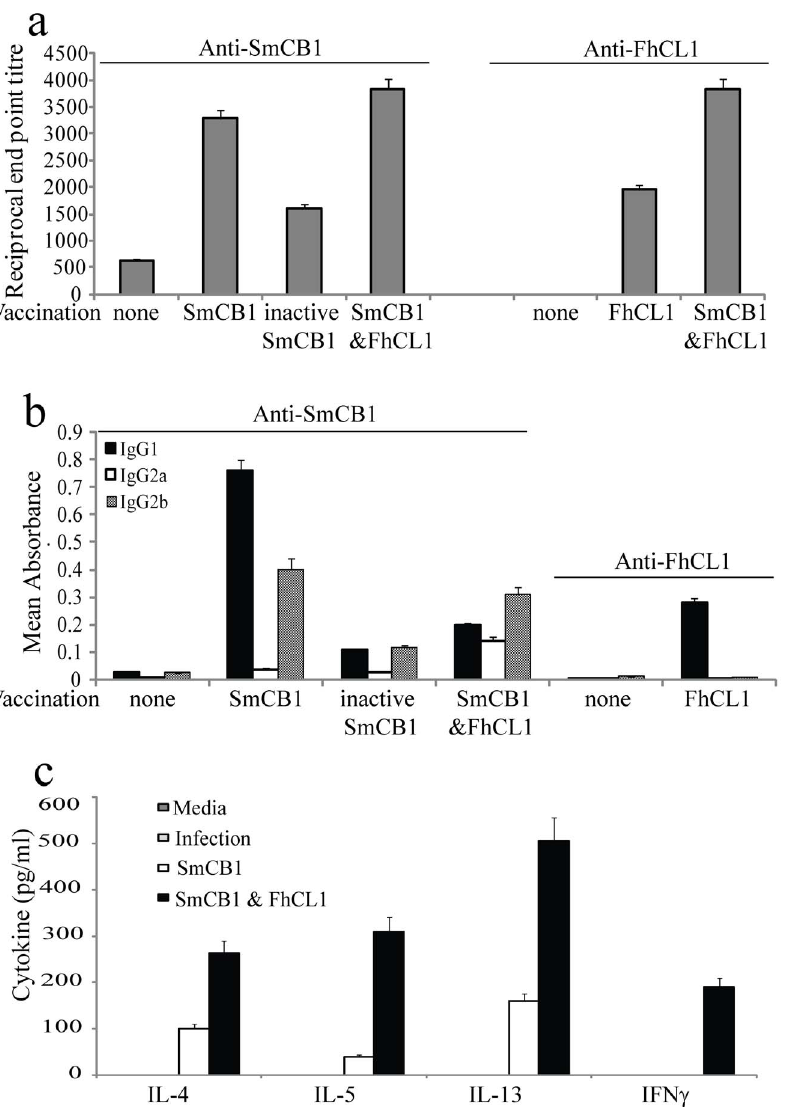
Figure 2. Effects of immunization with SmCB or FhCL without adjuvant on immune responses, assessed 6 days post infection. (a) Titres of peptidase specific IgG were measured in the sera of immunized mice by ELISA. The data shown is representative of 3 independent experiments and displays the inverse of the end point serum dilution. (b) The isotype of peptidase specific antibodies in the sera of mice was determined by ELISA. The data shown is representative of 5 independent experiments. Each column represents the delta mean absorbance 6 the standard error around the mean (SD). (c) Spleens were harvested from mice that were infected following immunization with SmCB1 or a combination of SmCB1 and FhCL1. The quantity of cytokine (IL-4, IL-5, IL-13 and IFN- c ) released into culture media by spleen cells stimulated with SmCB1 in vitro was measured by ELISA. Supernatants from cells incubated in media only served as negative controls. Each column represents the mean 6 SD.